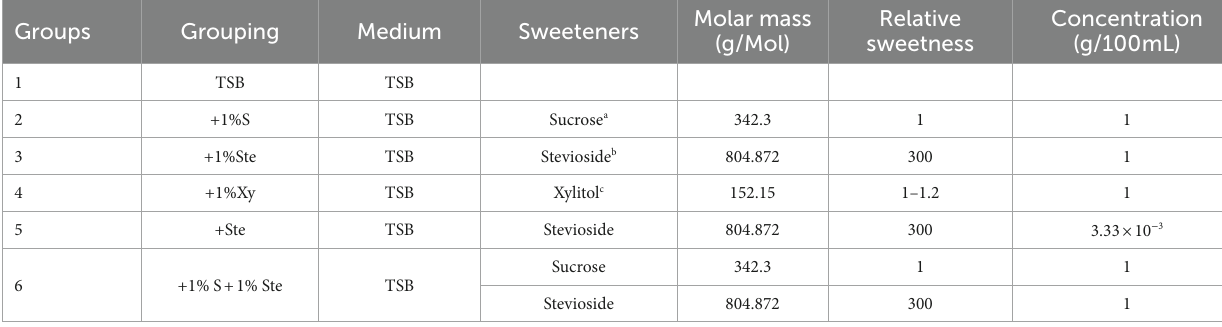
TABLE 1 Concentrations of stevioside and other sugars in growth medium.